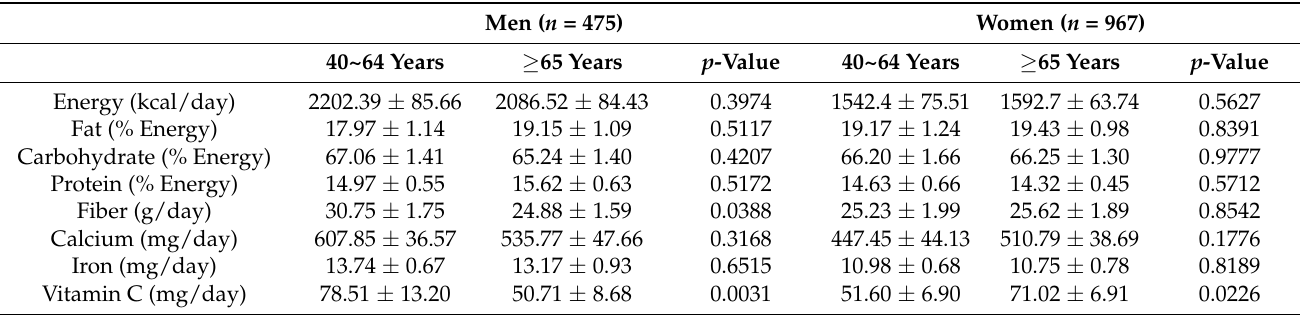
Table 3. Major intake calculated from 24-h recall method of study population in single-person households according to age